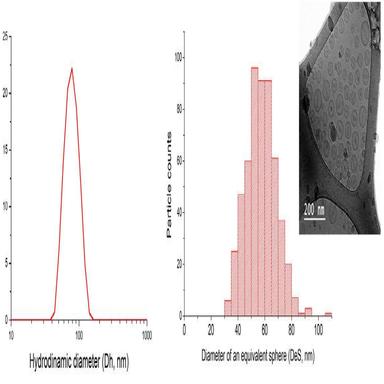
Transfer of the SOP from NCI-NCL (Lab3) to EUNCL (Lab1, Lab2). A) The fractogram (repeatability) and the Dg measured by Lab1 is shown as an example. B) Comparison of average size values and standard deviation of the mean obtained by AF4 analysis (geometric diameter, Dg and hydrodynamic diameter, Dh) in the three labs, and size values obtained by orthogonal analysis of the same batch, including batch-mode DLS (Int-Pk=Intensity based distribution, Num-Pk= Number based distribution), and cryo-TEM are reported;